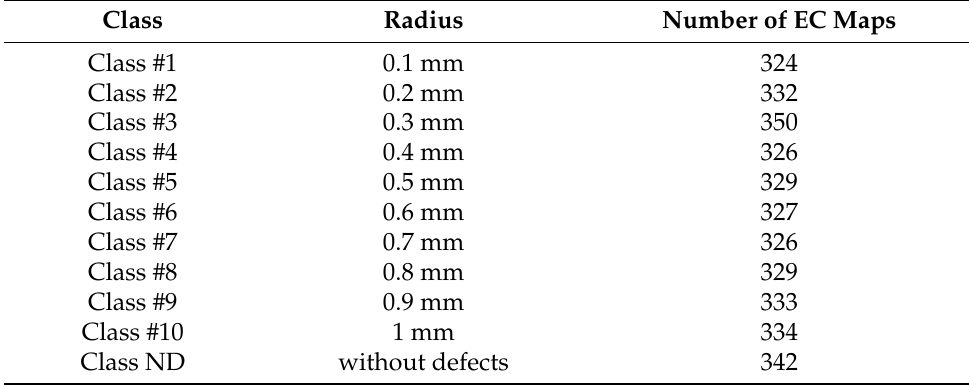
Figure 6. ( a ) The probe, mounted on a handling system to scan the CFRP plate, and ( b ) its construc- tion details. Table 2. Characteristics of the classes of defects obtained by COMSOL ®